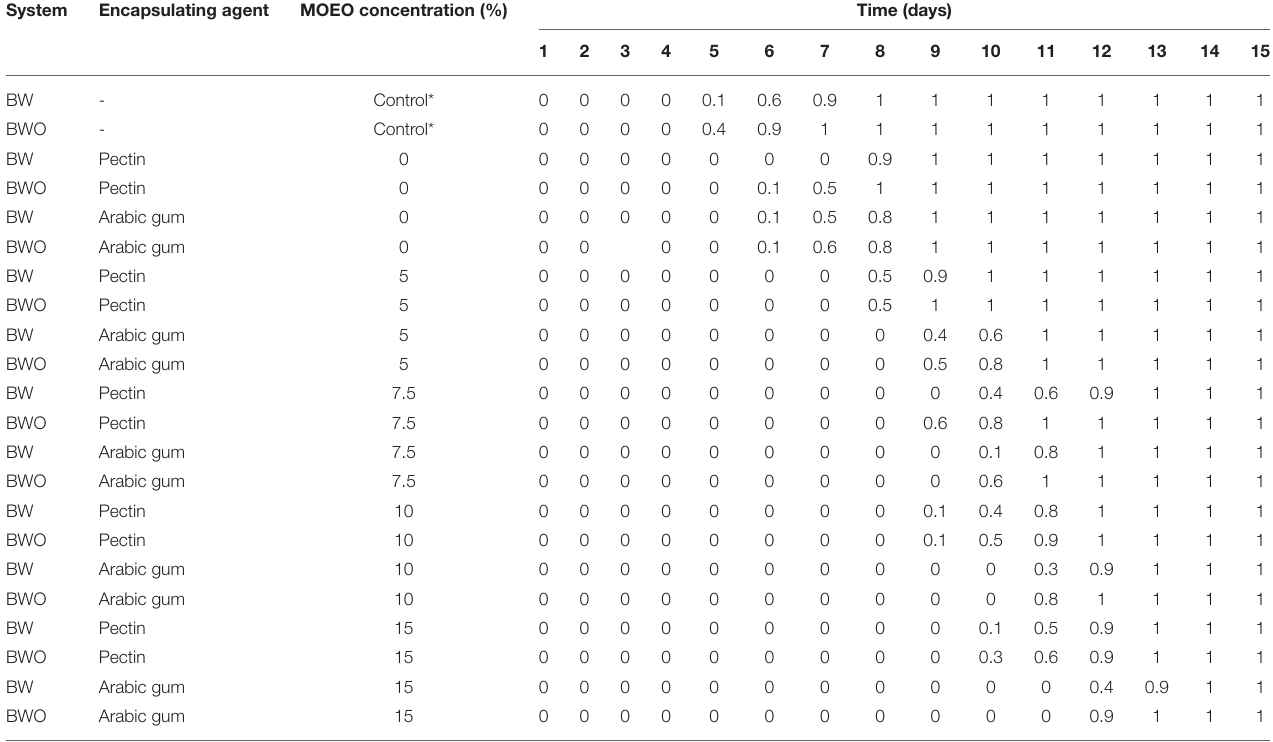
TABLE 6 | Growth of Penicillium expansum , represented as fractions of mold growth from eight inocula (1.5 × 10 7 CFU/ml, each), when emulsions with different concentrations of Mexican oregano essential oil (MOEO) stabilized with pectin or Arabic gum were applied on the surface of different bagel formulations during storage at 25 ◦ C.